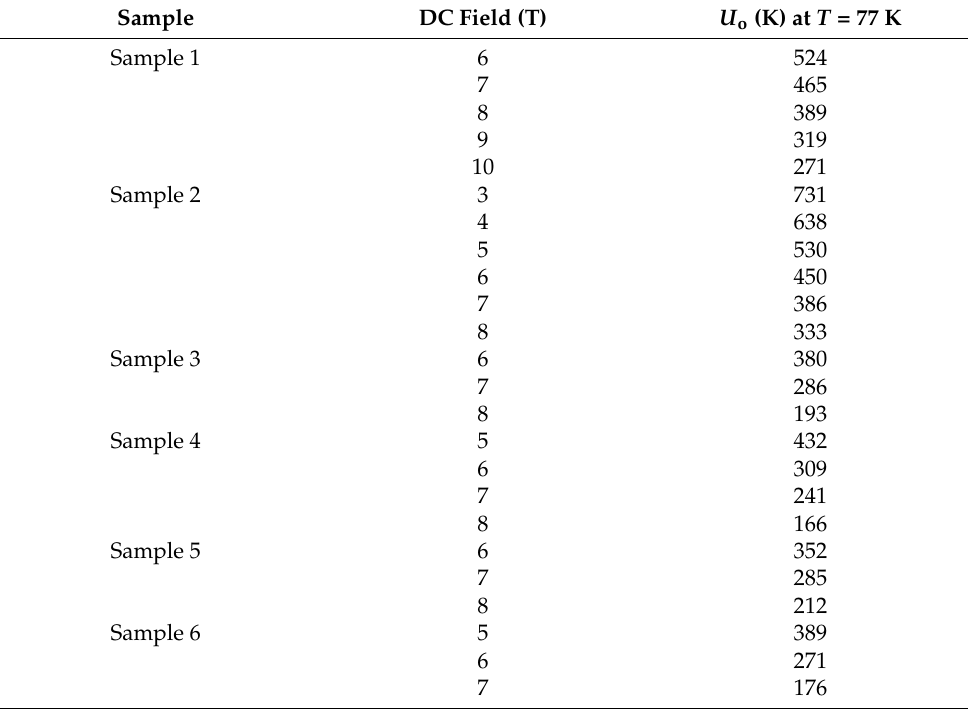
Table 1. Values of pinning potential estimated from slopes b in Figures 4–6, for Samples 1 to 6, in various DC magnetic fields, at 77 K.